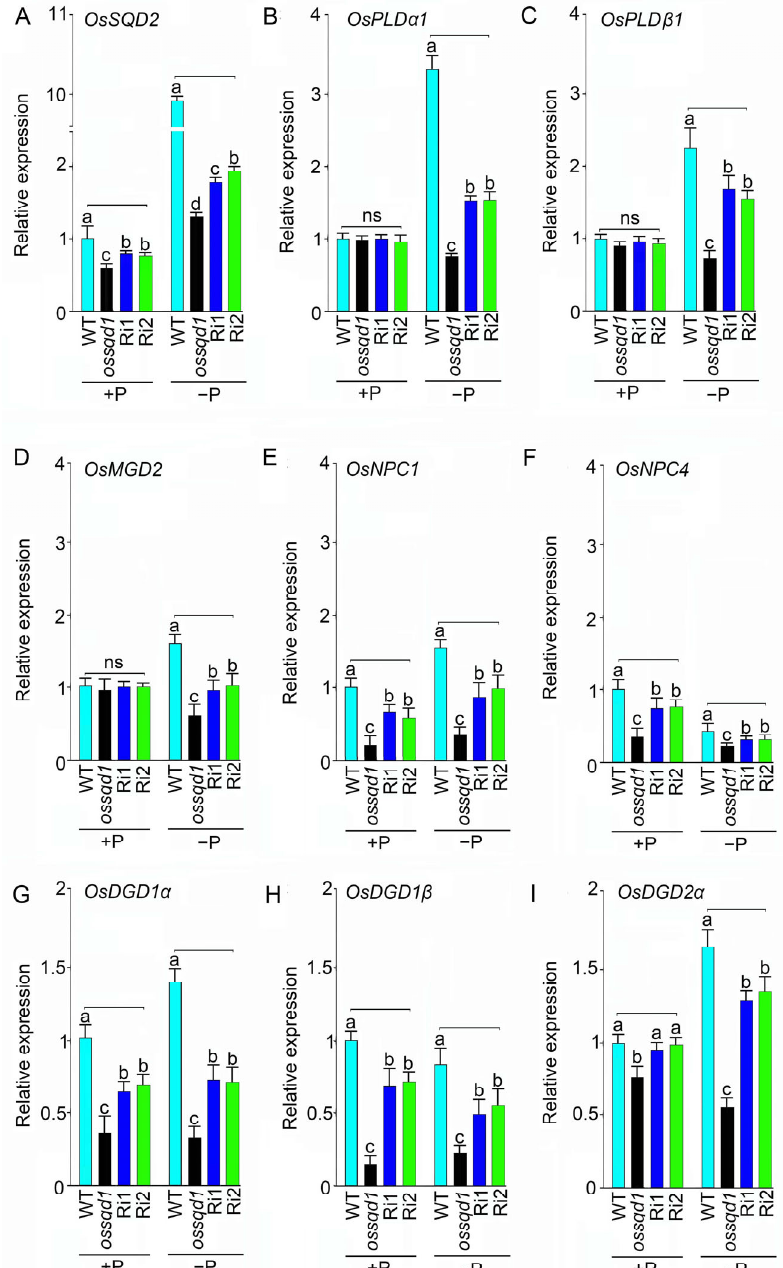
Figure 6. Knockout/down of OsSQD1 affects the relative expression of lipid biosynthesis ‐ related genes in roots under different Pi regimes. ( A – I ) Roots of WT, ossqd1 mutant, Ri1 and Ri2 were harvested for assaying the relative expression of the different lipid biosynthesis ‐ related genes ( A – I , OsSQD2.1 , OsPLD α 1 , OsPLD β 1 , OsPLD β 2 , OsMGD2 , OsDGD1 α , OsNPC1 , OsNPC4, OsDGD2 α and OsDGD1 β ) by qRT ‐ PCR analysis. OsACTIN were used as internal controls. Values are means ± SE ( n = 4). Different letters indicate that the values differ significantly between WT, ossqd1 mutant, Ri1 and Ri2 ( p < 0.05, one ‐ way analysis of variance, Duncan’s test).